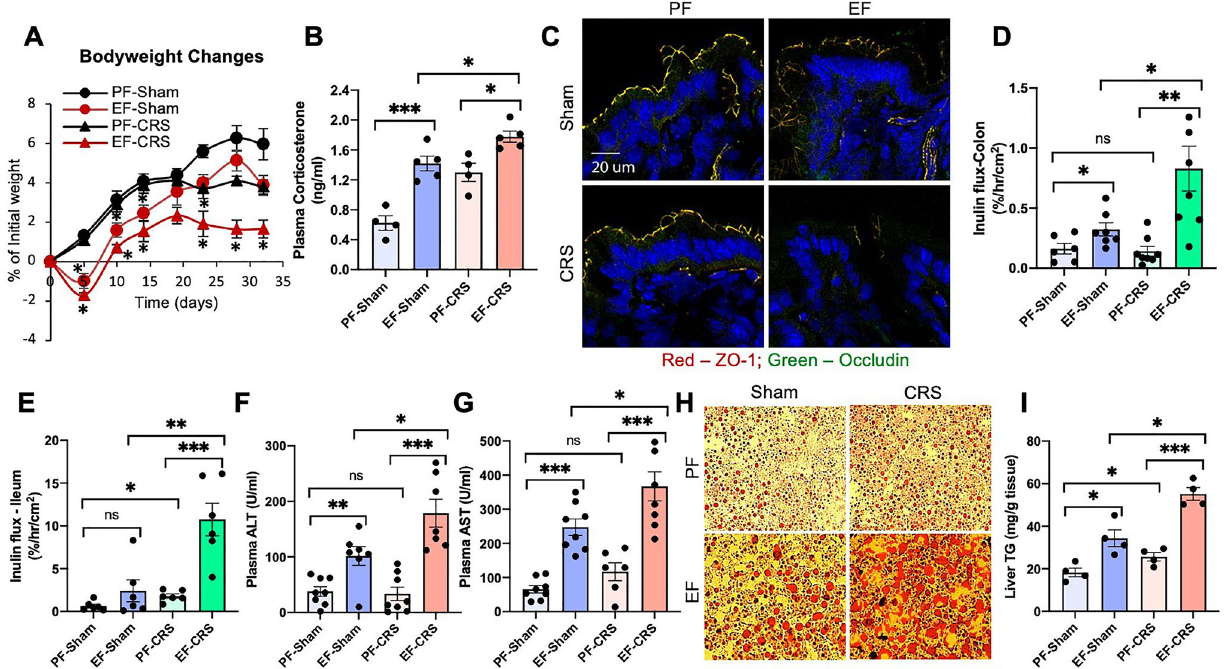
Figure 1. Chronic restraint stress synergizes alcohol-induced disruption of gut barrier dysfunction and liver damage. Adult mice were fed a liquid diet with (EF) or without (PF) ethanol for four weeks. In some groups, animals were subjected to two-hour restraint stress (CRS) or "Sham" treated. ( A ) Body weights were recorded twice a week. ( B ) Plasma corticosterone levels. ( C ) Epithelial tight junction integrity was assessed by staining cryosections of the colon for occludin and ZO-1 by immunofluorescence method followed by confocal imaging. ( D , E ) Mucosal permeability was measured by the vascular-to-luminal flux of FITC-inulin in the colon ( D ) and ileum ( E ) in vivo. ( F , G) ALT ( F ) and AST ( G ) activities were measured in plasma. ( H , I ) Liver sections were stained with Oil-Red-O for fat deposits ( H ). Liver extracts were analyzed for triglyceride content ( I ). Values in graphs are mean ± SEM (n = 6). Dots in bars indicate individual values. The numbers above the bars are p -values for differences between the groups indicated by the horizontal lines, and "ns" indicates no significant difference between